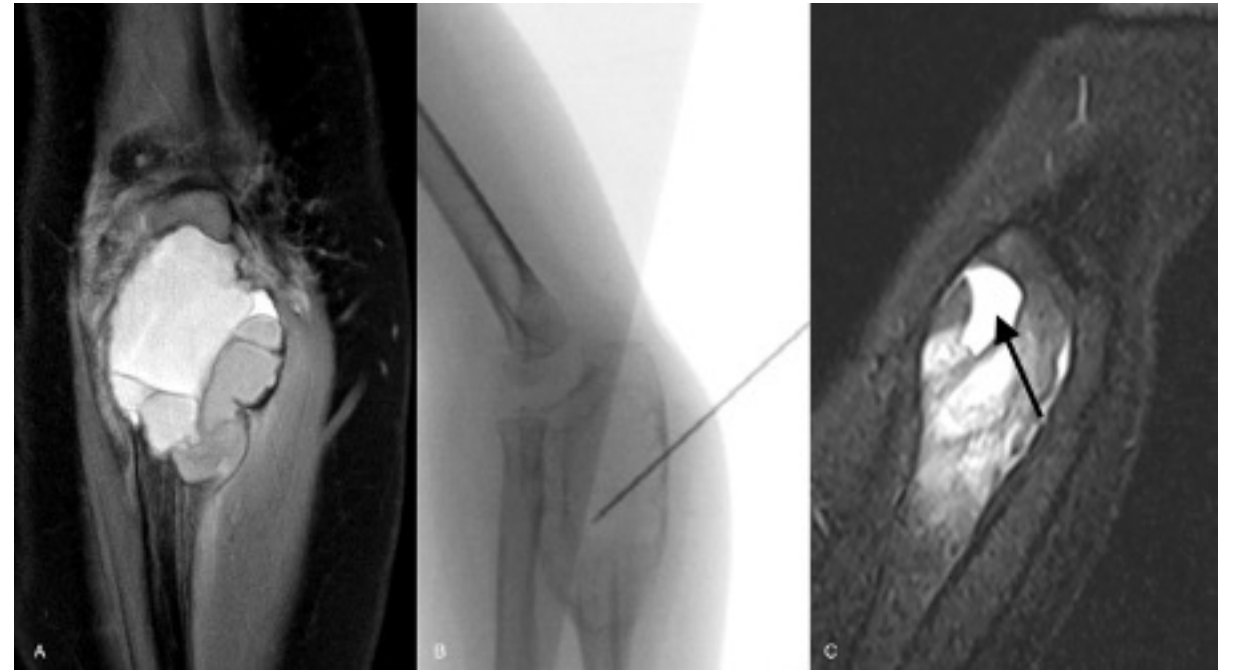
Figure 3. ABC of the proximal ulna of a 3-year-old girl—initial MRI scan ( A ); fluoroscopy of instillation of polidocanol ( B ); healing grade I according to Rastogi et al. with complete resolution of fluid-fluid levels (( C ): arrow).